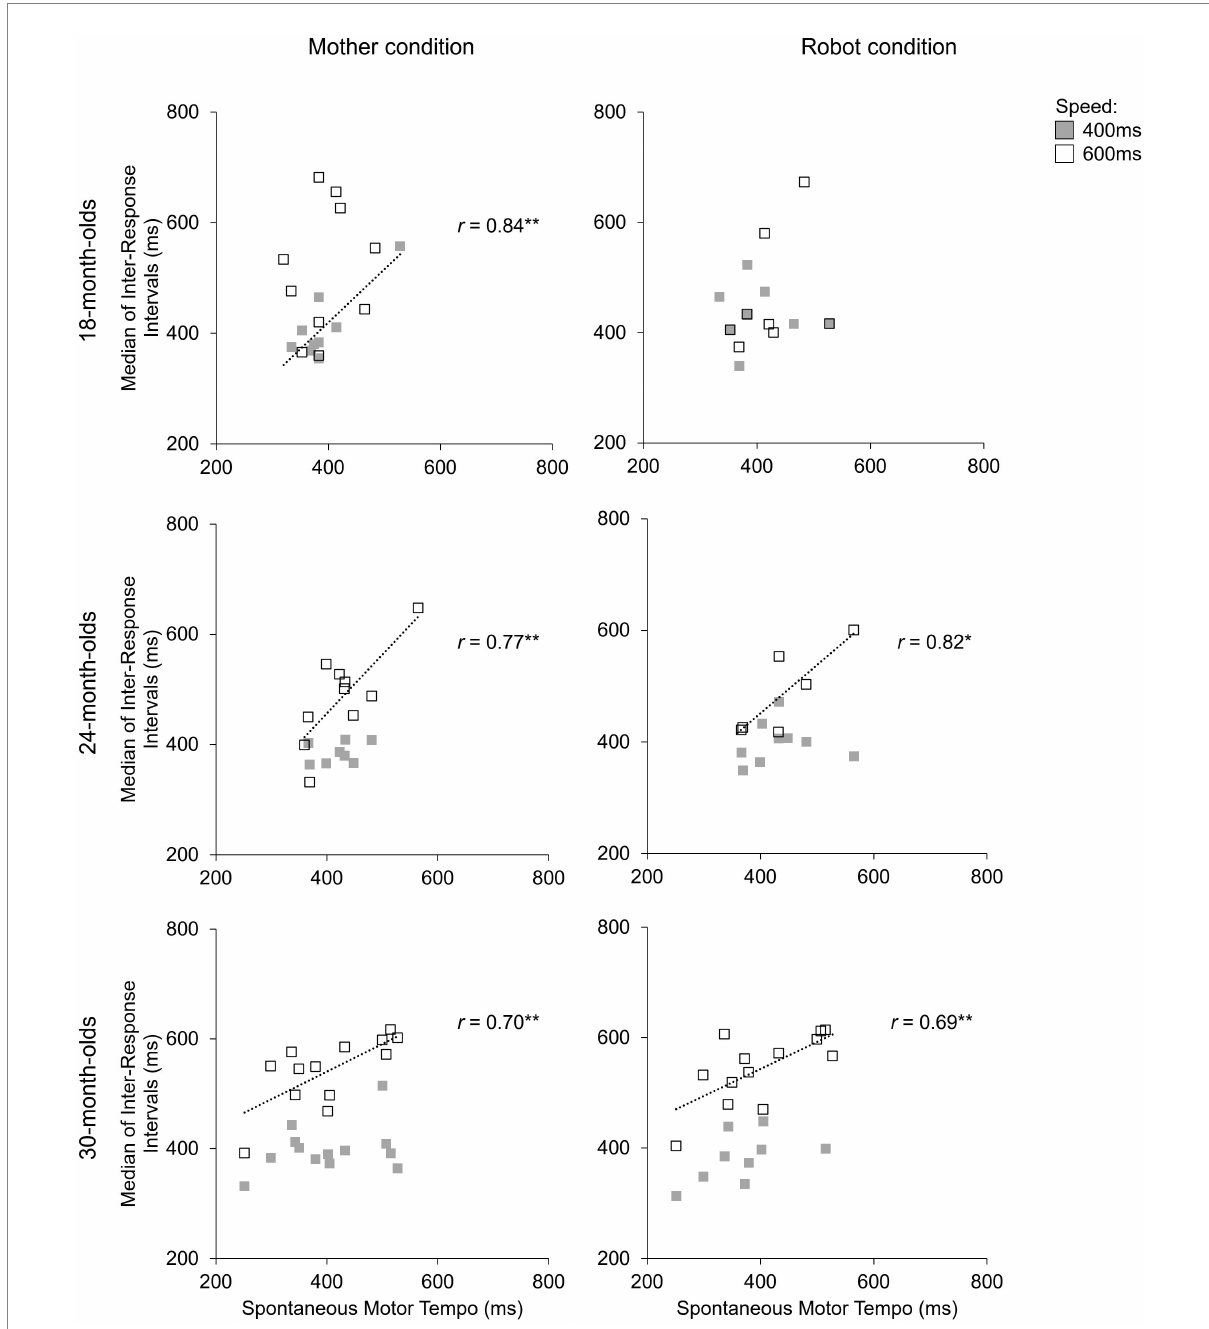
FIGURE 3 Correlation between the children’s spontaneous motor tempo (SMT) and the median of inter-response-intervals (IRIs) during the four test